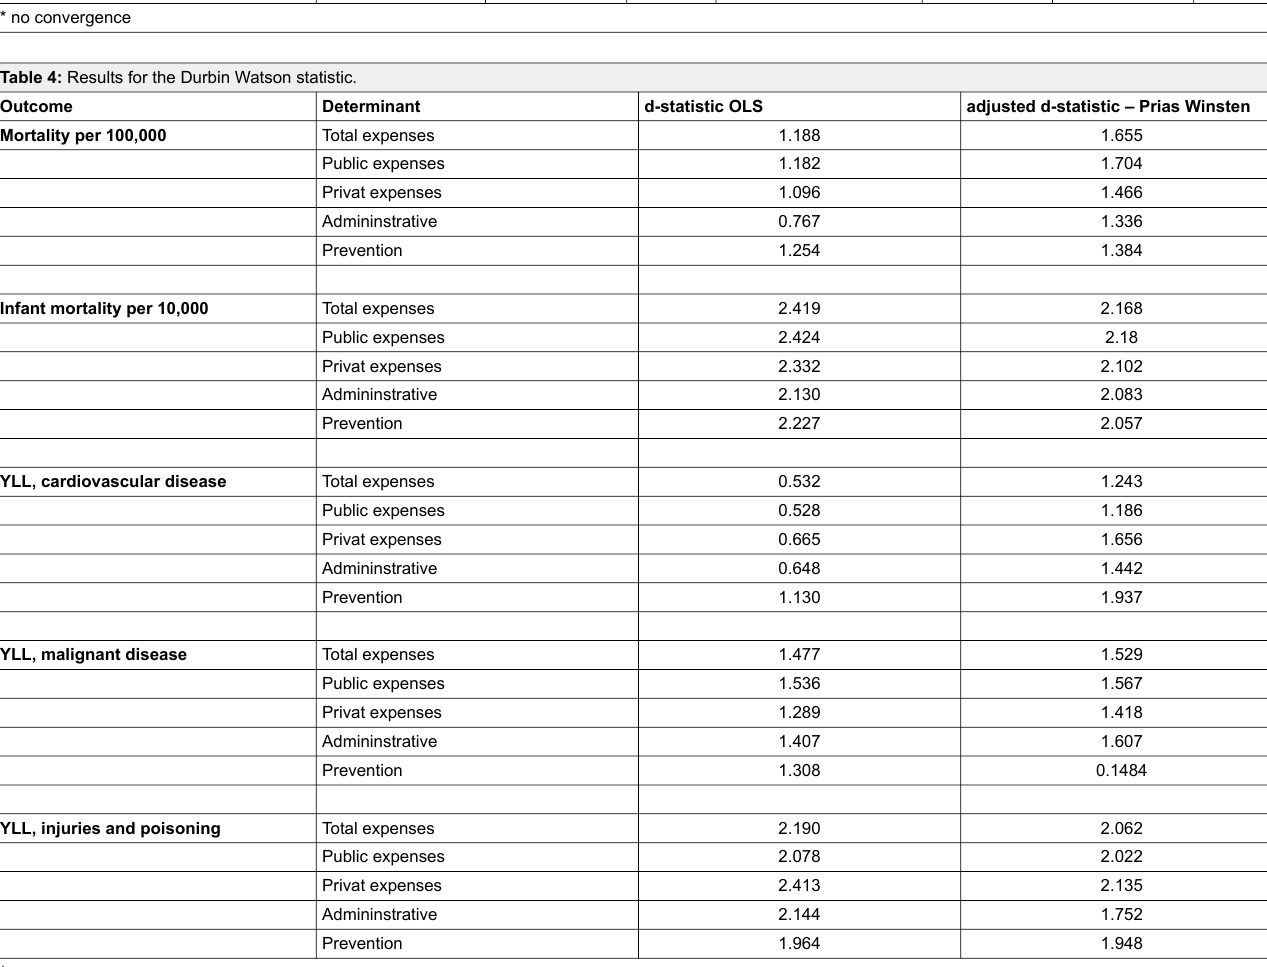
Table 4: Results for the Durbin Watson statistic.